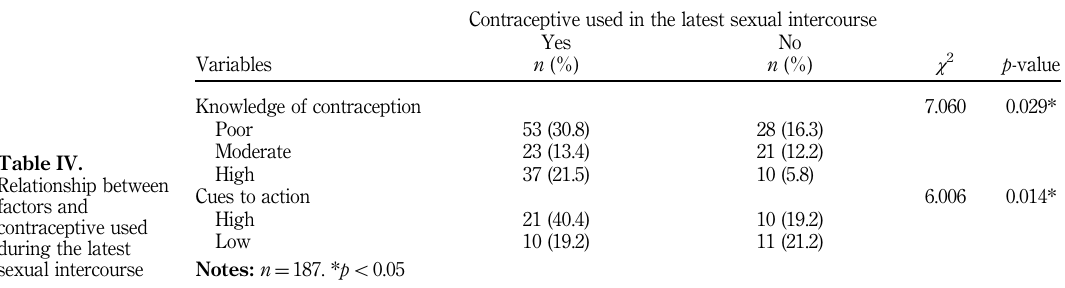
Table III. Relationship between factors associated with condom use during the latest sexual intercourse